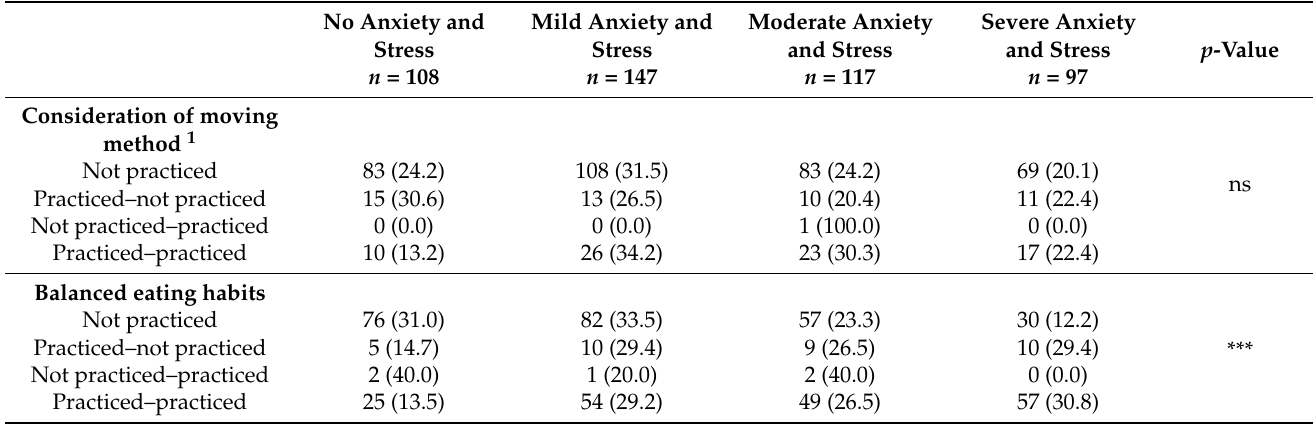
Table 7. Lifestyle of respondent groups with different levels of anxiety and stress during the COVID-19 pandemic. No Anxiety and Mild Anxiety Stress